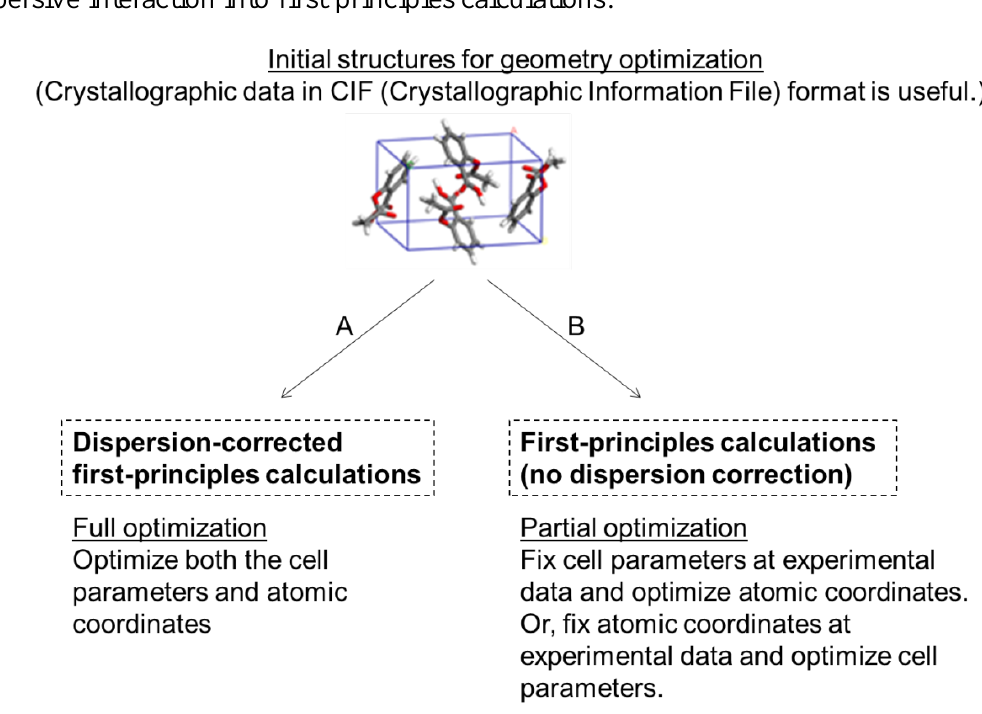
Figure 7. Two alternatives ( A , B ) in the geometry optimization process for incorporating a dispersive interaction into first-principles